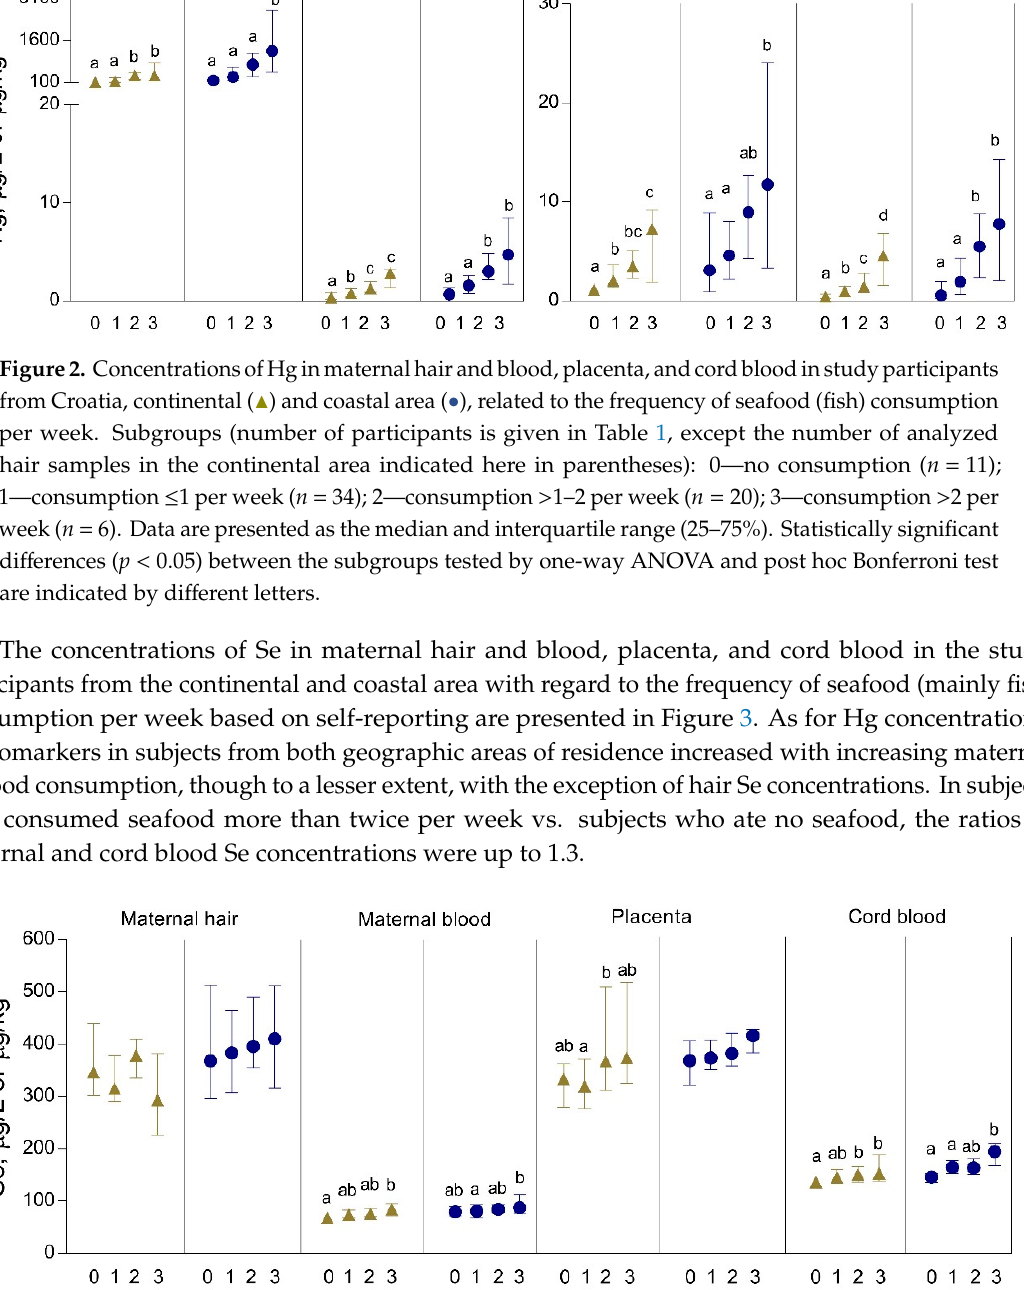
Figure 3. Concentrations of Se in maternal hair and blood, placenta, and cord blood in the study participants from Croatia, continental ( ▲ ) and coastal area ( ● ), related to the frequency of seafood (fish) consumption per week. Subgroups (number of participants is given in Table 1, except the number of analyzed hair samples in the continental area indicated here in parentheses): 0—no consumption ( n = 11); 1—consumption ≤ 1 per week ( n = 34); 2—consumption >1–2 per week ( n = 20); 3—consumption >2 per week ( n = 6). Data are presented as the median and interquartile range (25%–75%). Statistically significant differences ( p < 0.05) between the subgroups tested by one ‐ way ANOVA and post hoc Bonferroni test are indicated by different letters.